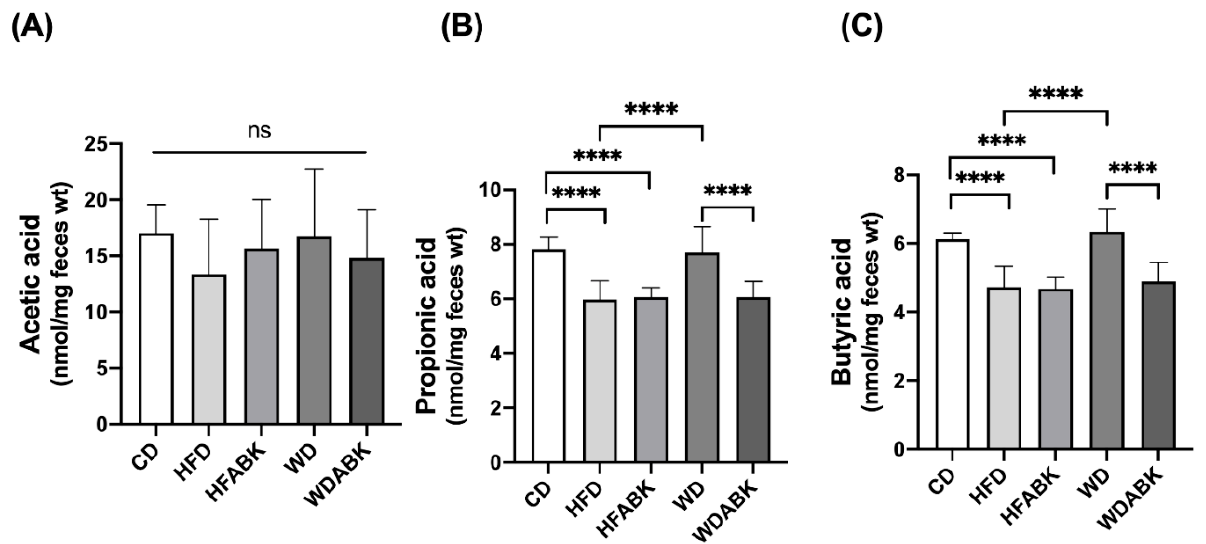
Figure 6. Effect of AB-Kefir on fecal SCFA level in HFD- and WD-fed mice. Level of ( A ) acetic, ( B ) propionic, and ( C ) butyric acid in feces are shown. Data are expressed as mean ± S.D. (n = 8 per group) **** p < 0.0001. Statistics were analyzed by using one-way ANOVA with Tukey’s post hoc test.